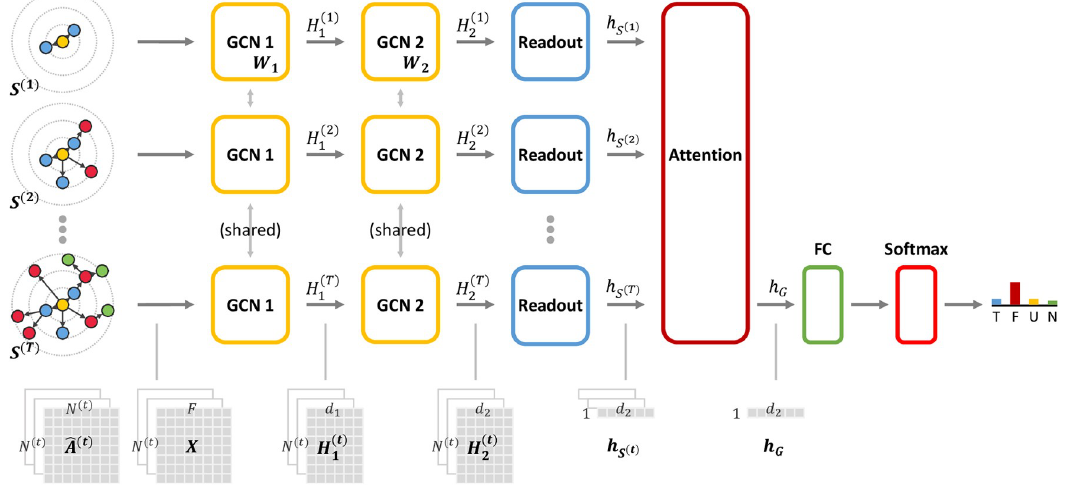
Fig 2. The overall architecture of Dynamic GCN rumor detection model with its layers and inputs’ dimensions for each layer.